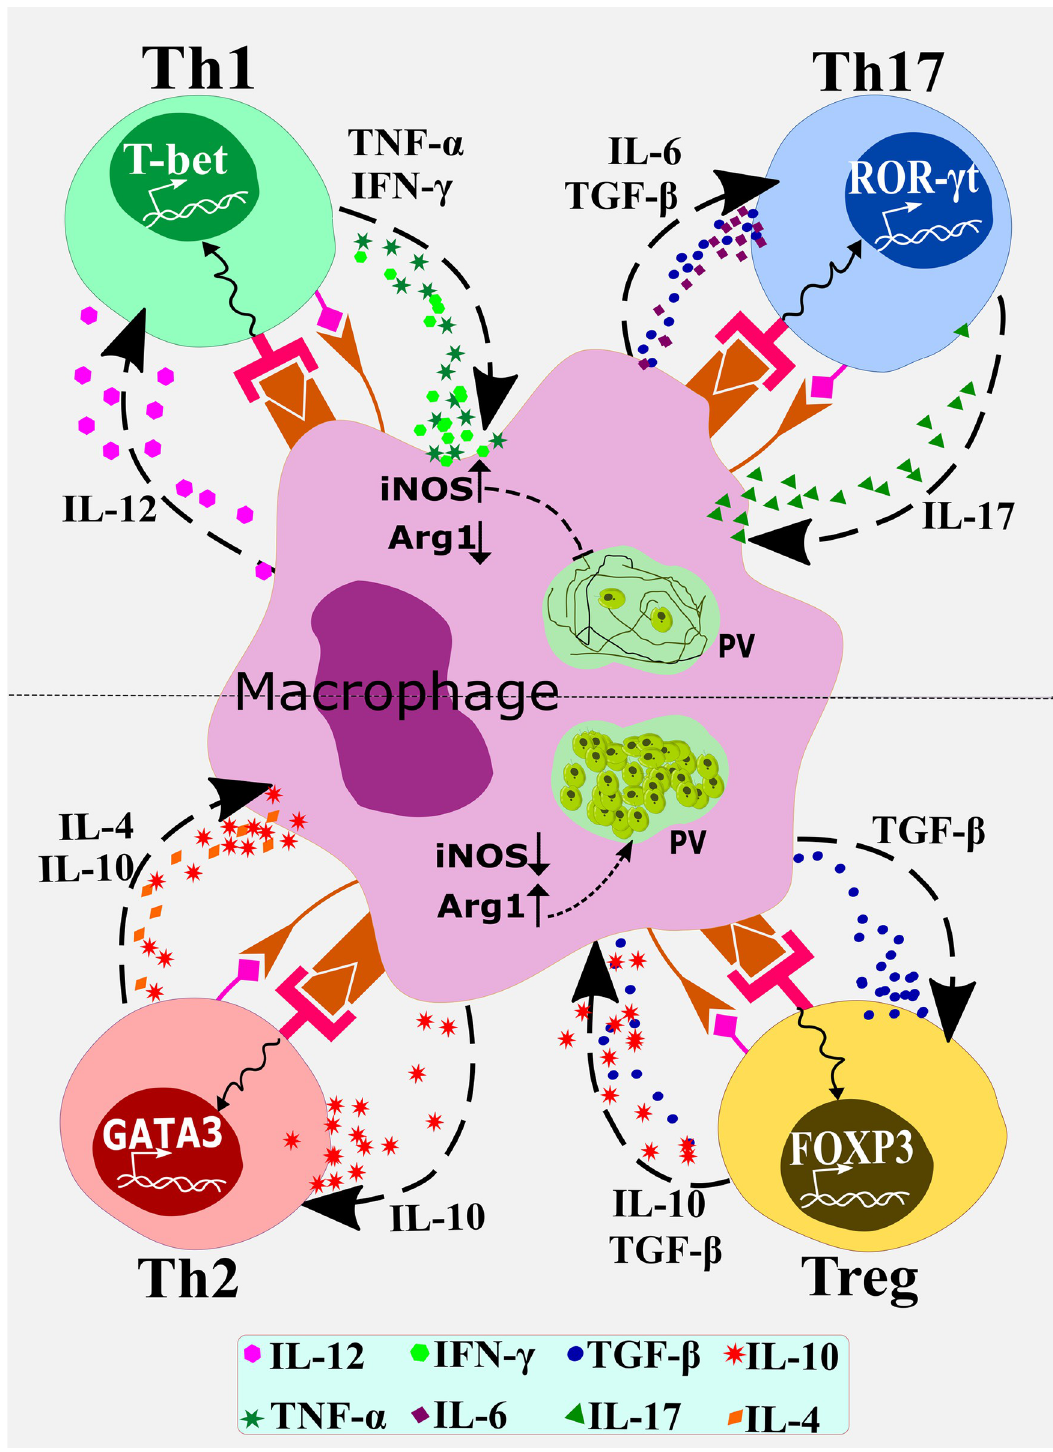
Fig 1. A basic macrophage-T cell subset differentiation scheme that counteractively regulates the alternative outcomes of Leishmania infection. AU : AbbreviationlistshavebeencompiledforthoseusedinFigs 1 to 5 : Pleaseverifythatallentriesarecorrect : Macrophages are the host cells for the protozoan parasite Leishmania (PV with amastigotes are shown in green). The top half (above the broken line) shows the condition when Th1 and Th17 cells are differentiated in presence of the respective signature transcription factors T-bet and ROR- γ t. These cells activate macrophages to induce iNOS but to reduce arginase (Arg1). iNOS catalyzes the formation of nitric oxide that kills the amastigotes within macrophages. The bottom half shows the